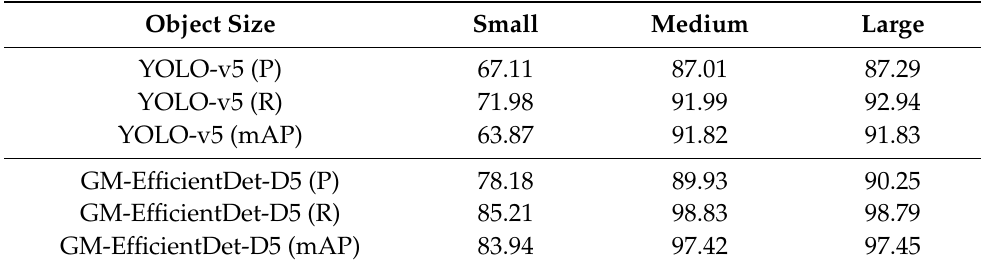
Table 5. Comparisons of detection performance for different sizes of apple flowers. (P): Precision, (R): Recall (in